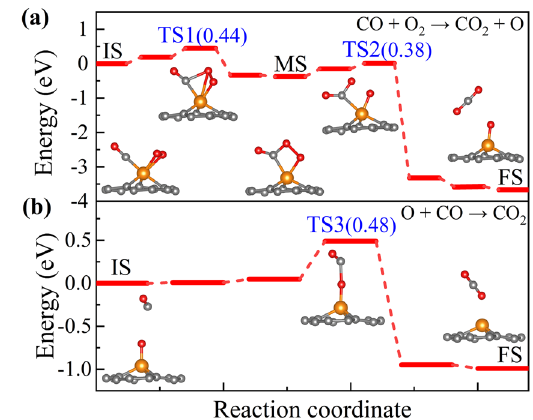
Fig. 6 Energy pro fi les of CO oxidation reaction. a The fi rst step via LH mechanism, CO + O 2 → CO 2 + O. b The second step, O + CO → CO 2 . Atomic structures of the initial (IS), transition (TS), and fi nal (FS) states are shown. Energy barriers (in eV) needed to reach TS are given in brackets. Color scheme used is the same as